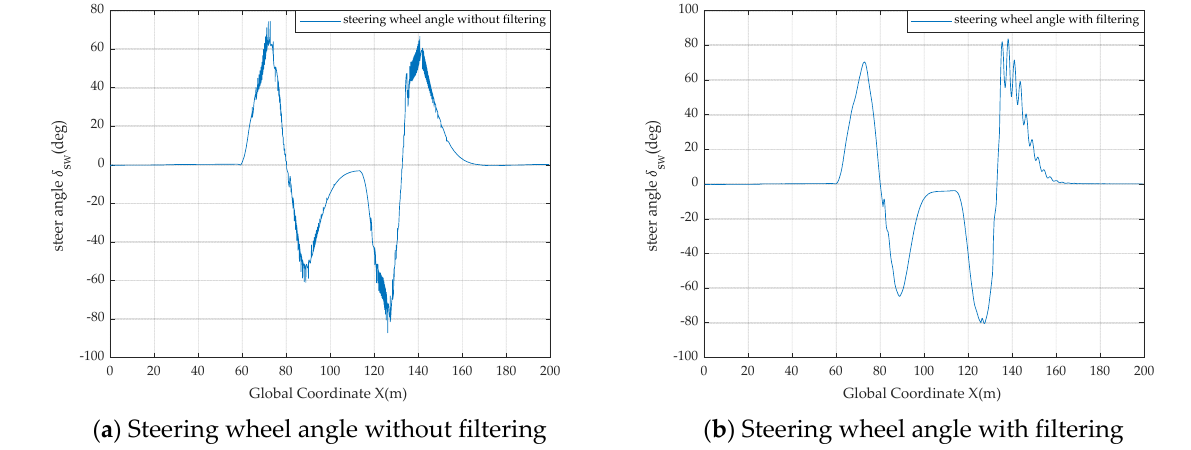
Figure 7. The steering wheel angle with and without filtering at RAC = 0.5 and VS = 10 m/s.